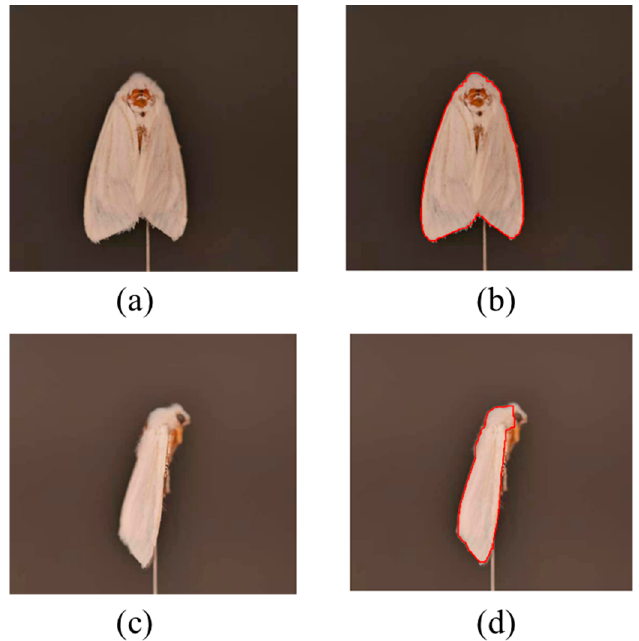
Figure 7. Edge tracking results of H. cunea : ( a ) back view image; ( b ) edge extraction from a back view image; ( c ) right-wing perspective image; and ( d ) edge extraction from a right-wing perspective image.